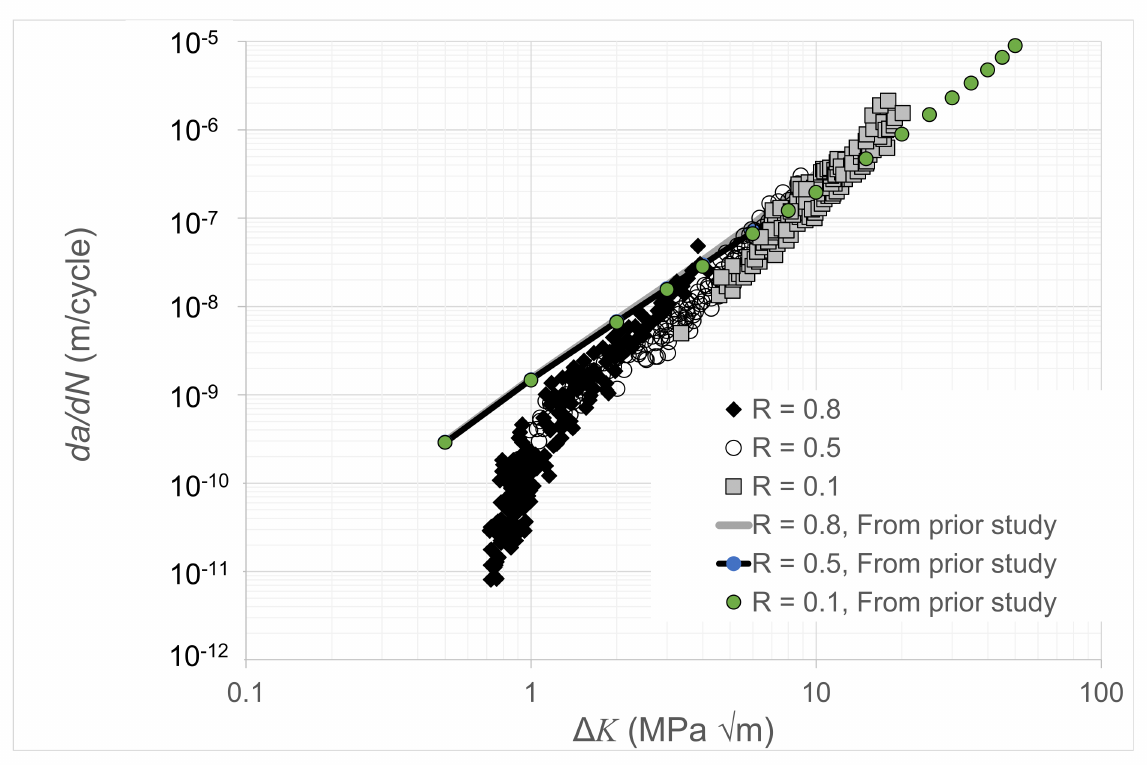
Figure 2. The measured small crack curves given in [44] for the growth of small cracks in AA7075- T7351 together with the predicted worst-case small crack curve given in [46] for this